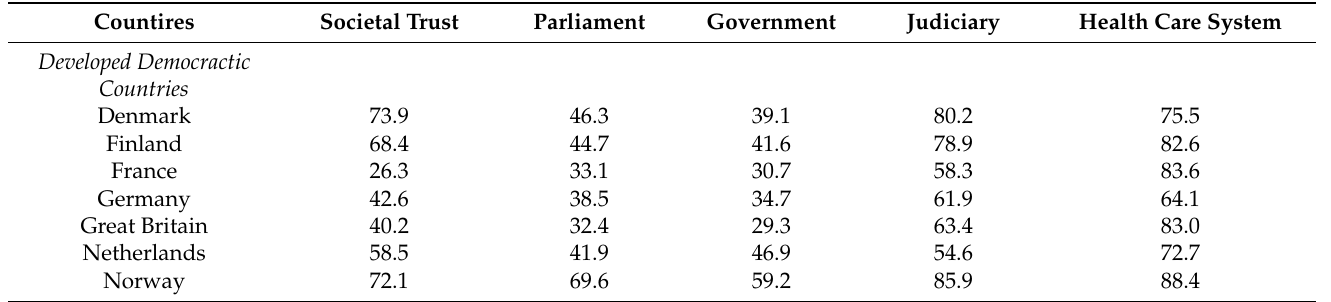
Table 1. Societal trust and trust in important institutions in Europe 2017/2018 (in percentage,